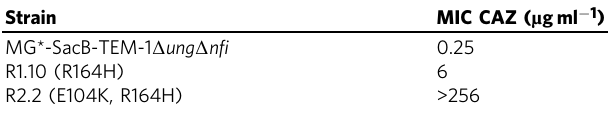
Table 2 Minimal inhibitory concentration (MIC) to ceftazidime (CAZ) of parental strain and evolved